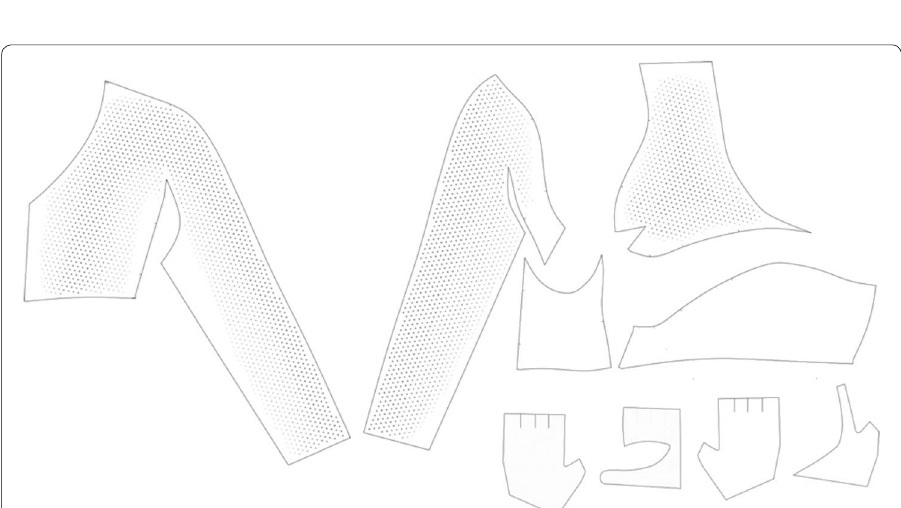
Fig. 18 Clay pigeon glove and harness product patterning (Echols 2018a)